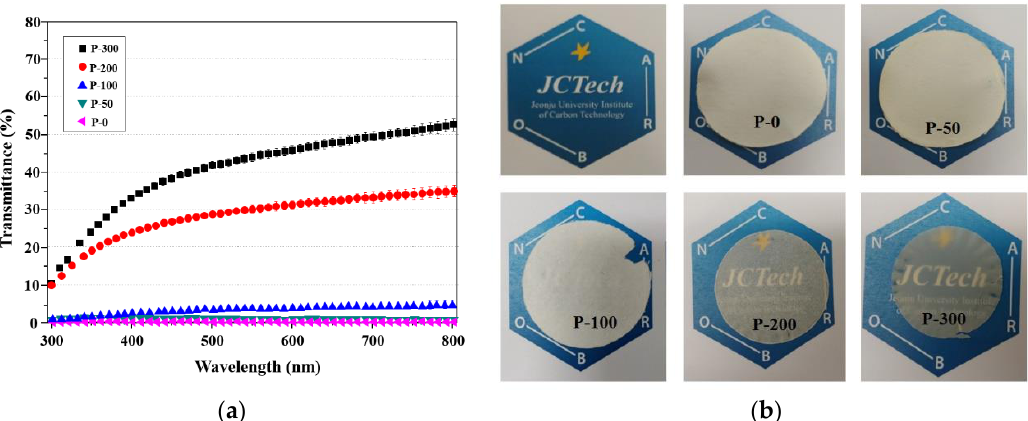
Figure 4. Visible light transmission performance. ( a ) UV–vis transmission spectra and ( b ) photographs of paper samples prepared from P-0, P-50, P-100, P-200, and P-300, respectively.